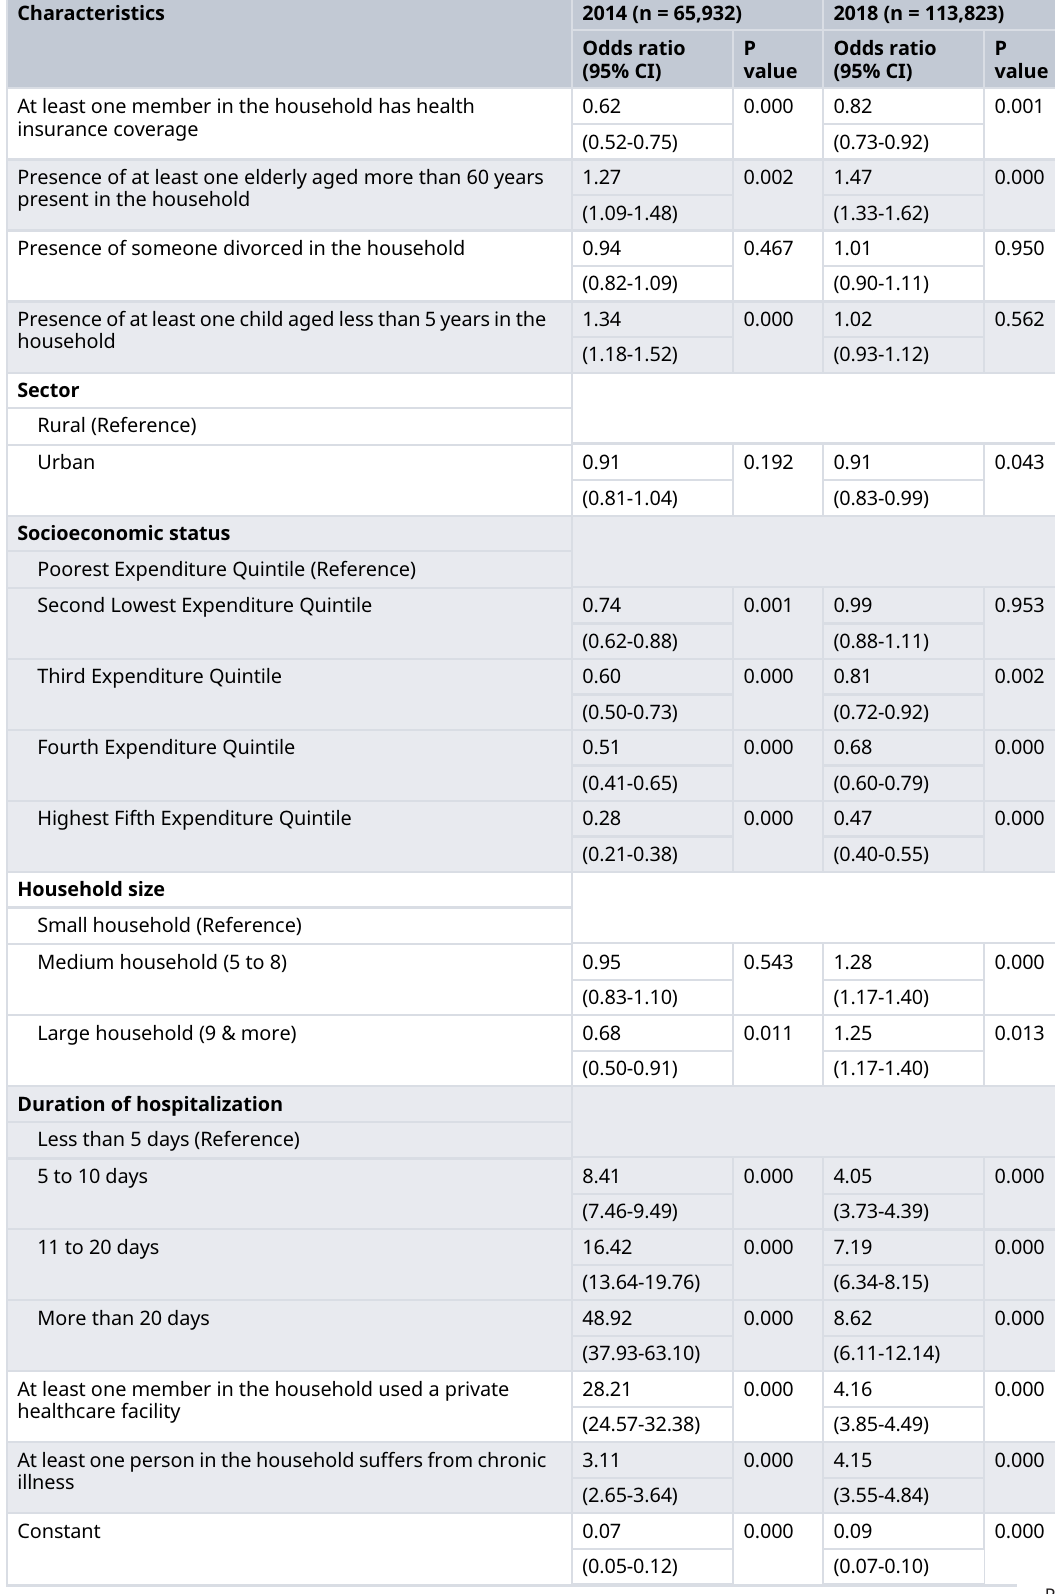
Table 5. Logistic regression for the factors affecting incidence of CHE.